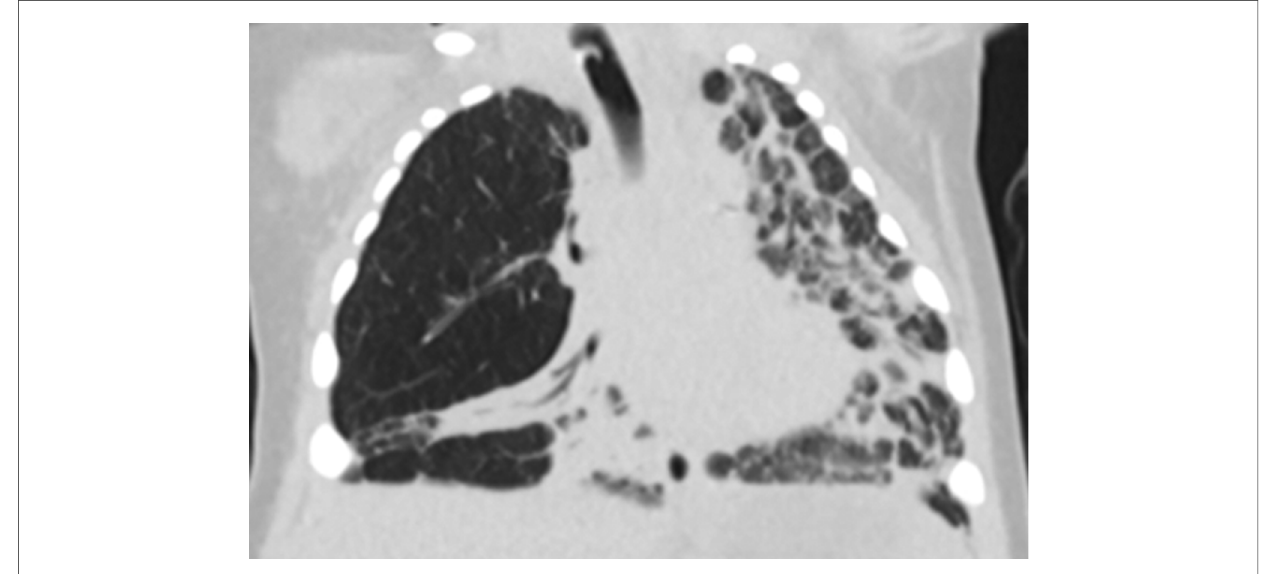
FIGURE 3 Chest computed tomography of an 8 month old former 26 week premature infant with severe BPD demonstrating dramatic pulmonary heterogeneity with alveolar simpli fi cation of the right upper lobe and diffuse fi brosis of the left lung. The patient is also severely hyperin fl ated with fl attened